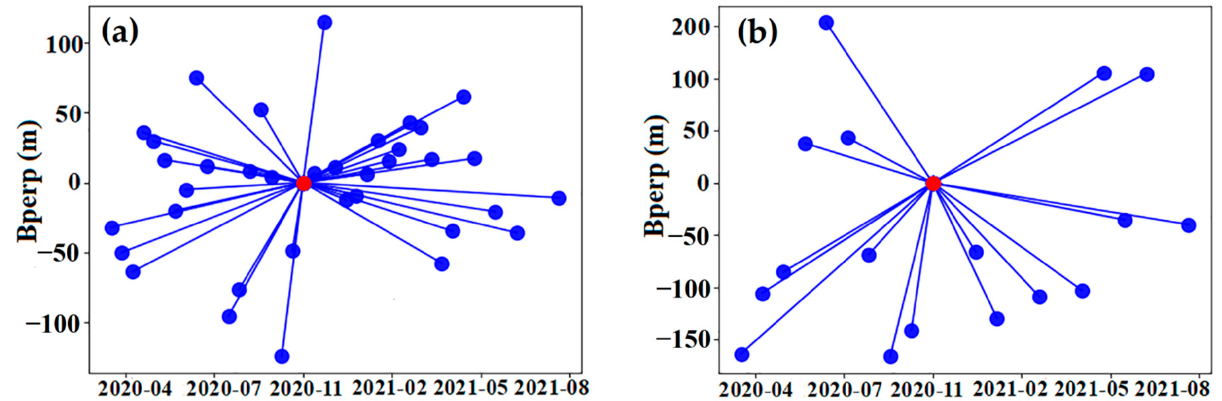
Figure 3. Spatial-temporal baseline distribution of Sentinel-1A and Radarsat-2 data (red circle represents the reference image, blue circle represents the slave images, and blue lines indicate the formation of an interferogram). ( a ) Sentinel-1A. ( b ) Radarsat-2. Table 2. Basic parameters for the SAR data in the Yuxi study area.